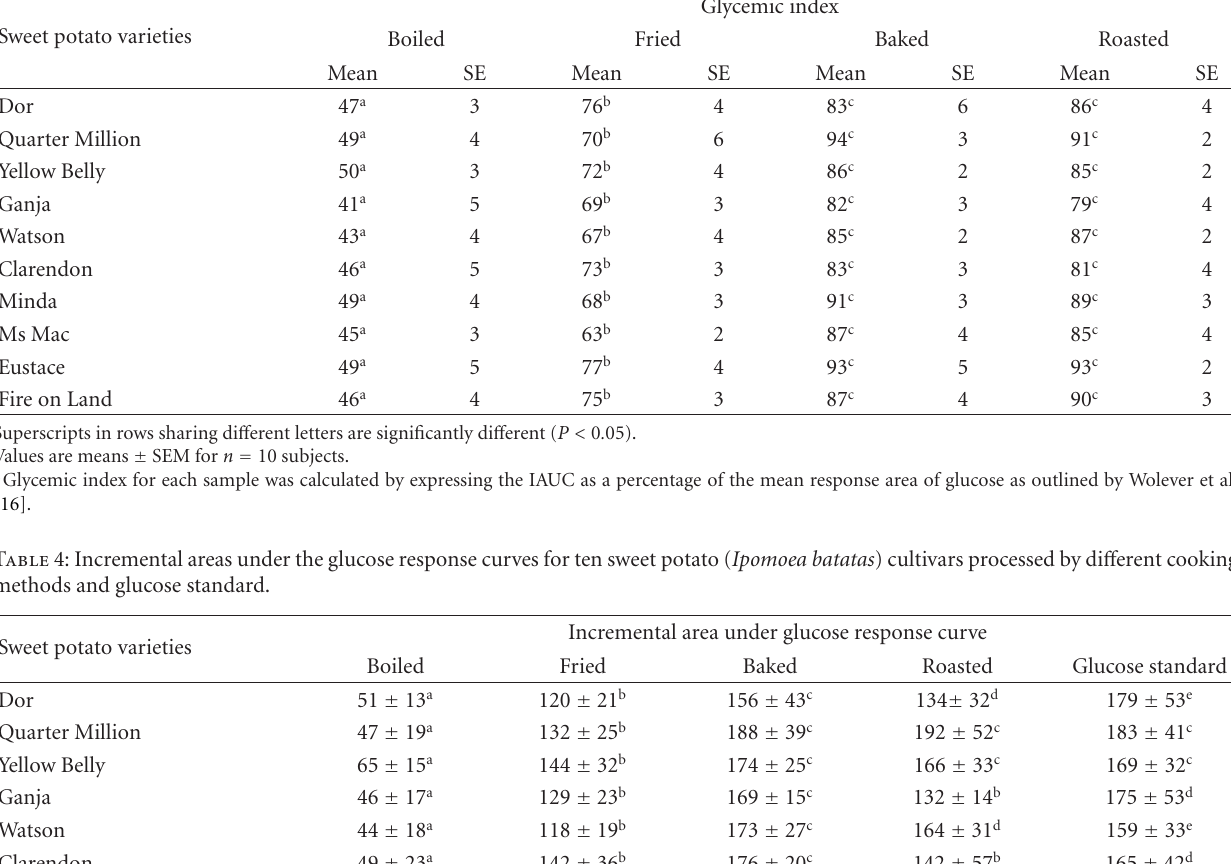
Table 3: Glycemic indices § of selected Jamaican sweet potato ( Ipomoea batatas ) varieties determined by di ff erent cooking methods. Glycemic index Sweet potato varieties Boiled Fried Baked Roasted Mean